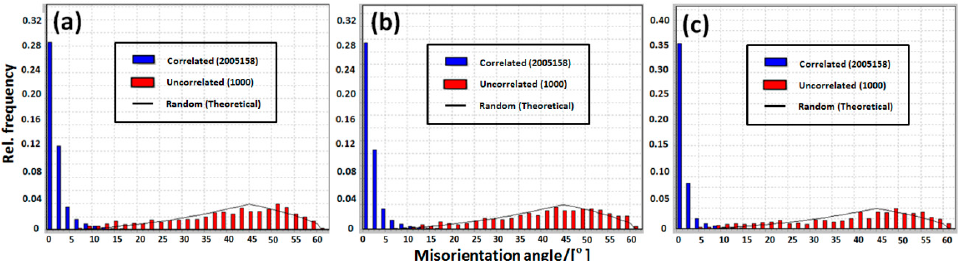
Figure 5. Misorientation angle distribution of the grain boundaries under ( a ) dry, ( b ) lubricating oil, and ( c ) polyphosphate lubricant conditions at 700 °C.